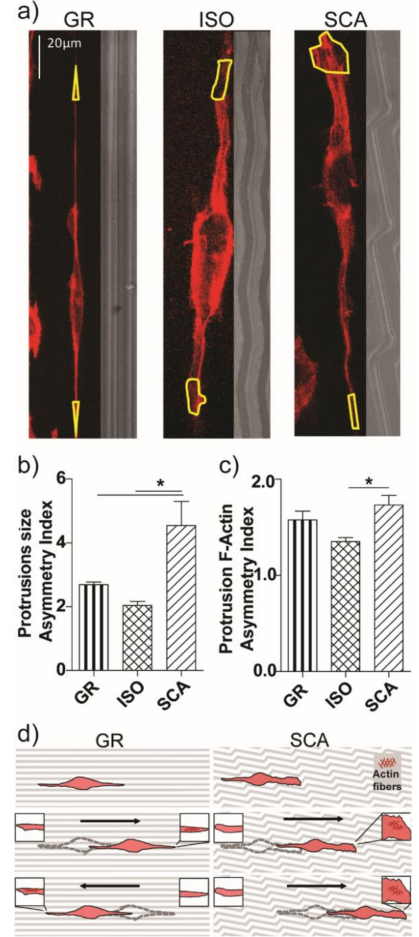
Figure 7. Cell asymmetry on SCA membranes. ( a ) Confocal representative images of single RT4-SCs cultured on GR, ISO, SCA chitosan membranes and stained for actin fibers (red), with the protrusion area drawn in yellow; scale bar = 20 µ m. ( b ) Cell protrusion size asymmetry index: the ratio of the protrusions’ area (the ratio between the area of the bigger cell’s protrusion over the minor one), as a parameter of the cell-end asymmetry; * p < 0.05 SCA vs. GR and ISO, one-way ANOVA, Bonferroni’s test. ( c ) Cell protrusion F-Actin asymmetry index: the ratio of the F-actin intensity between the two cell protrusions (i.e., the F-actin mean intensity of the bigger protrusion and the minor one, for each cell), as a parameter of the cell-end contractility asymmetry; * p < 0.05 SCA vs. ISO, one-way ANOVA, Bonferroni’s test. Data = mean ± SEM, n ≥ 3. ( d ) Model of the asymmetric development and directional migration of RT4-SCs on SCA chitosan substrates. Cell–substrate interactions modulate the actin cytoskeleton organization and fiber formation (inset: dark-red mashes) and control the direction of migration. The symmetry of the pattern influences these processes, promoting or demoting differently the spreading dynamics at the two cell edges on GR or SCA. The black arrows indicate the cell migration